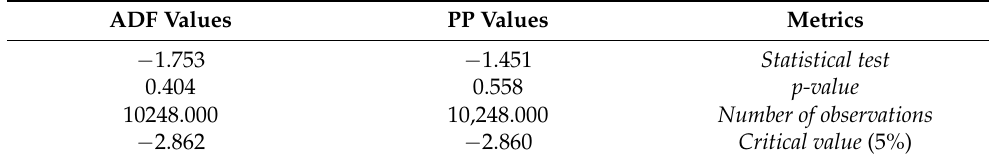
Table 1. Time series analysis.